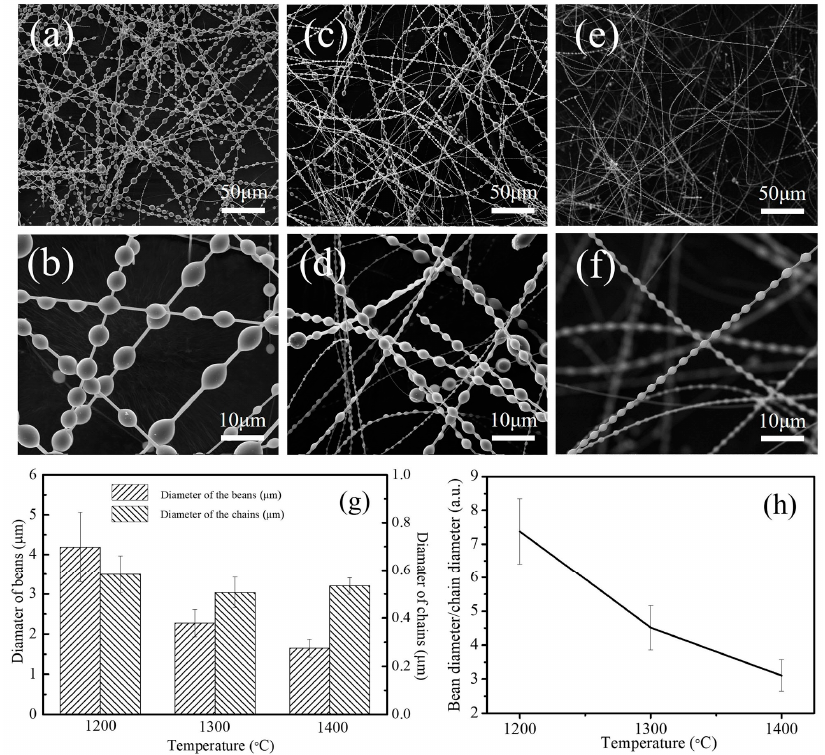
Figure 2. Scanning electron microcopy (SEM) images of the as-achieved products as a function of the firing temperature, ( a , b ) 1200 °C; ( c , d ) 1300 °C; ( e , f ) 1400 °C; ( g ) histogram for the diameter of the beans and chains in a necklace-like structure; ( h ) line chart representing the ratio of the beans’ diameter to the chains’ diameter.